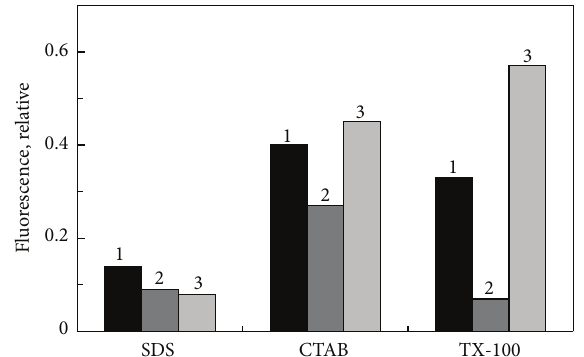
Figure 7: Relative pyrene fluorescence intensity in aqueous micellar media with SDS, CTAB, and TX-100: (1) prior to sorption, (2) after sorption on the CDA fiber, and (3) on the CDA fiber.